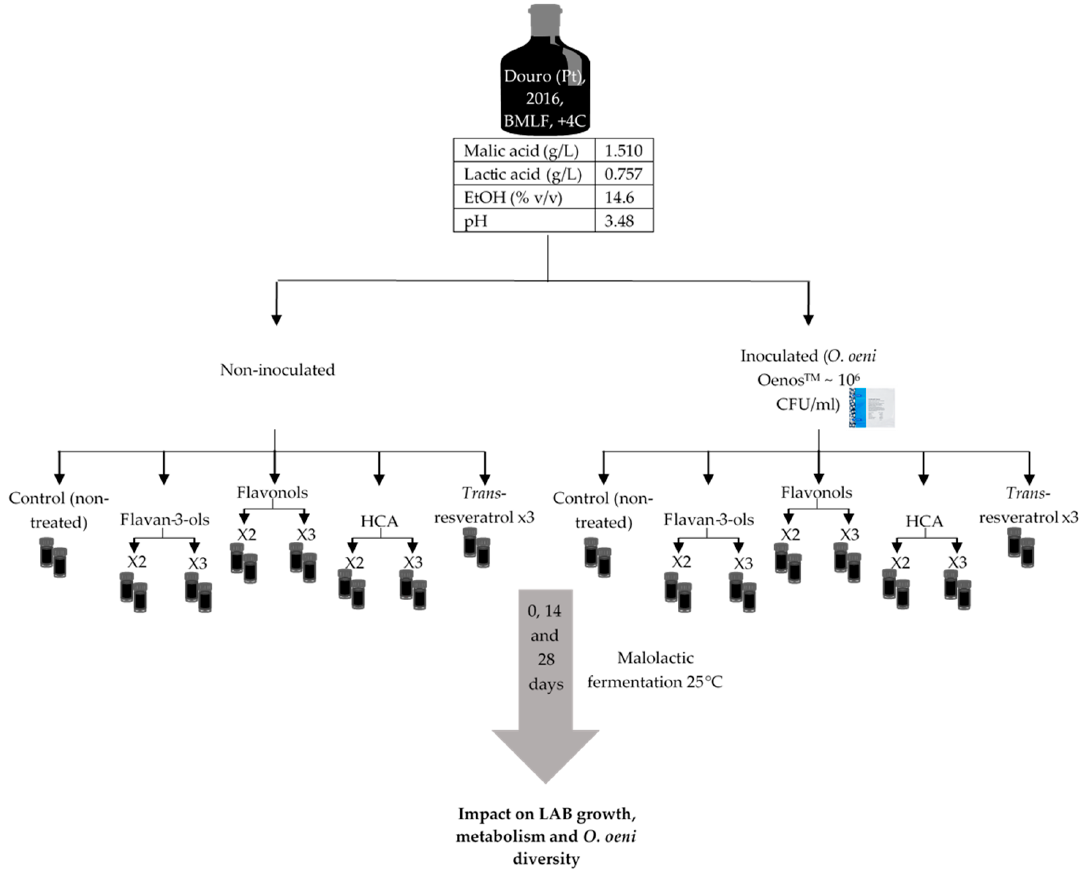
Figure 3. Overall experimental process. Table 4. Minimal and maximal concentrations (mg/L) in phenolic compounds in wines (during